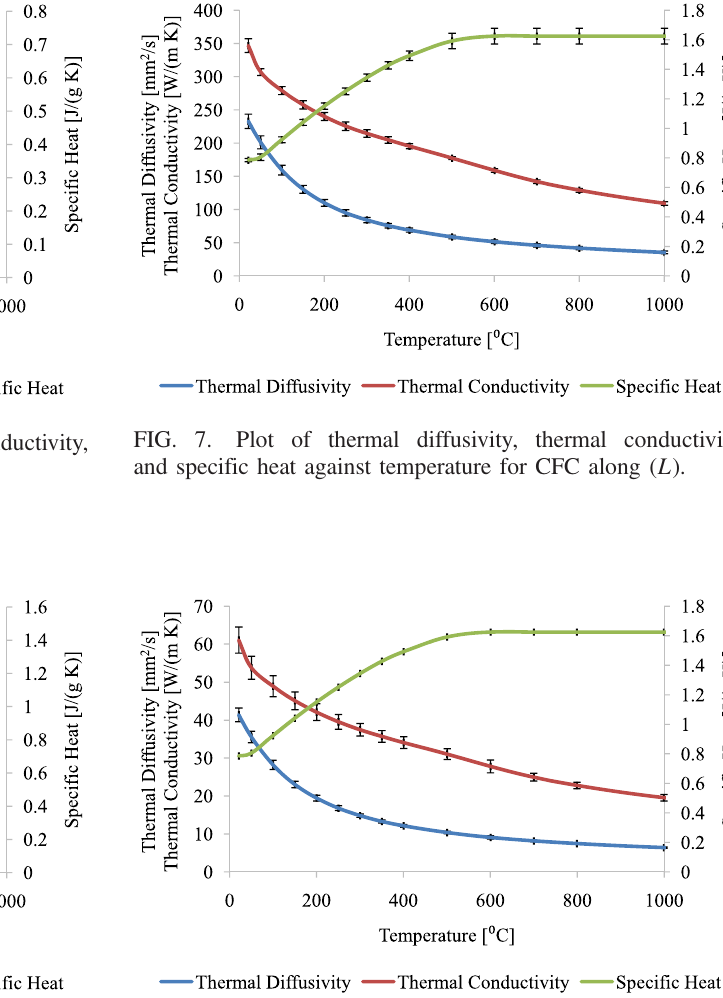
FIG. 5. Plot of thermal diffusivity, thermal conductivity, and specific heat against temperature for MoGr along ( L ).